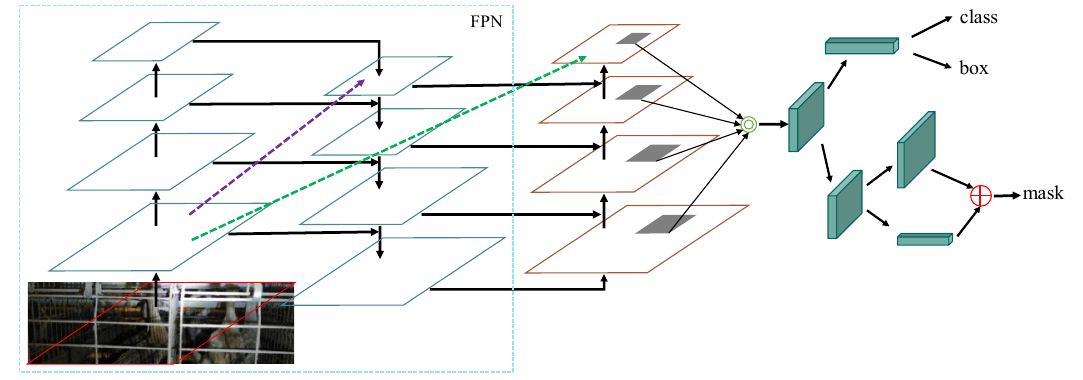
Figure 8. PANet network structure.